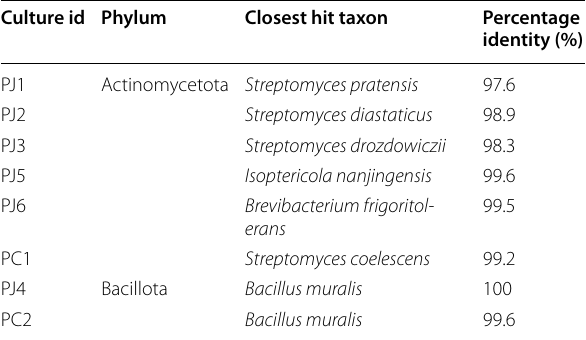
Table 1 16S rRNA gene sequence identity of the axenic bacteria isolated from the rhizosphere of P. juliflora (PJ) and P. cineraria (PC) Culture id